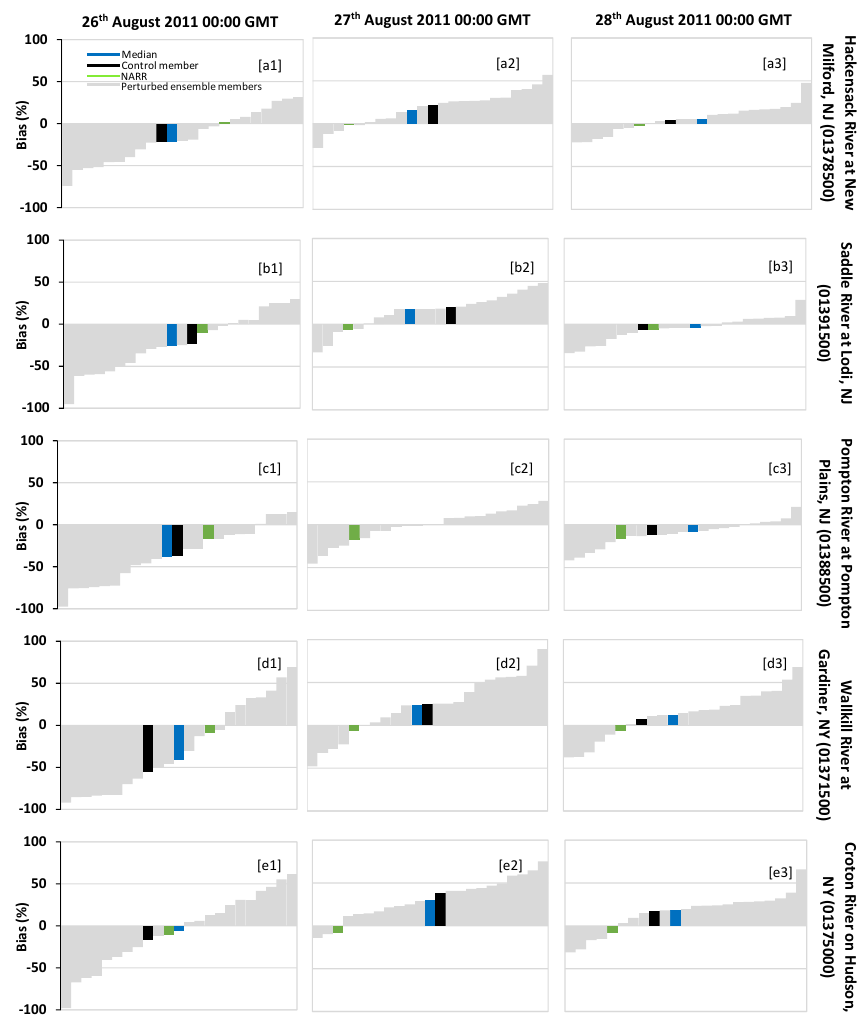
Figure 7. Models’ performance represented by BIAS (%) at lead times of 72, 48 and 24h from the observed peak flow. The metrics are showing the NARR model outputs, the median of ensemble members and the GEFS control member. The GEFS perturbed members are shown in